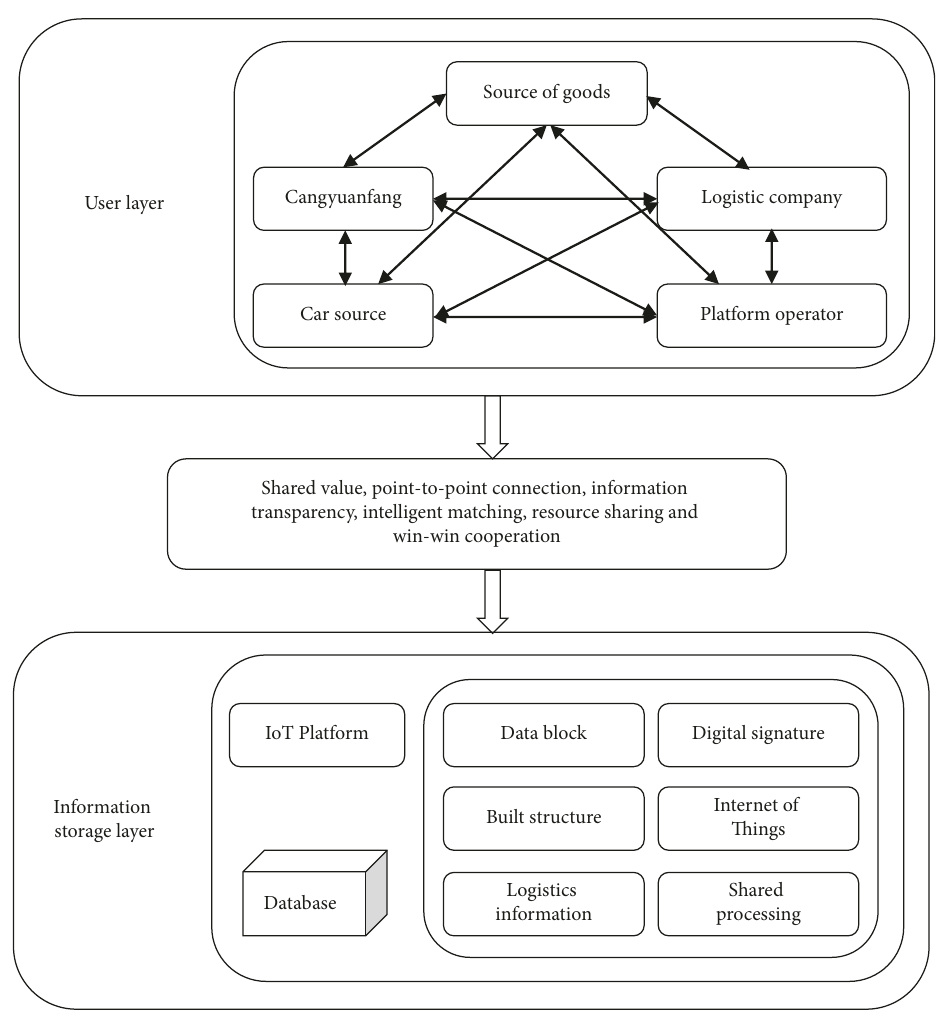
Figure 1: The infrastructure of the logistics distribution information sharing